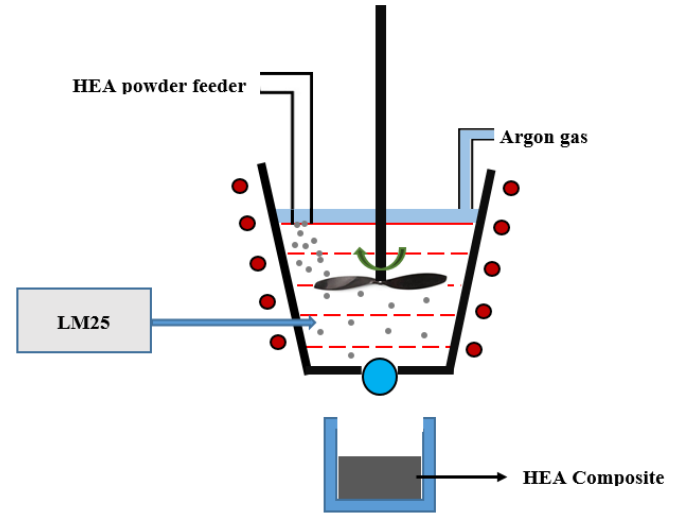
Figure 1. Schematic representation of stir casting furnace and composite production. Representative composite pieces were cut from the cast bar and subjected to standard metallographic sample preparation techniques (using standard metallographic procedures), and finally were etched with Kellar’s reagent. The microstructures of the composites were observed under an Olympus GX41 inverted microscope. A field-emission scanning electron microscope (FESEM, Gemini-300, ZEISS, Jena, Germany) with a combined energy- dispersive X-ray spectroscope (EDS) feature identified elemental composition as well as surface morphology. The X-ray diffraction analysis was carried out using a Rigaku Ultima IV XRD unit (Rigaku, Stuttgart, Germany) (with Cu-K α radiation: λ : 1.5406 Å), which functioned at 30 mA and 40 kV by recording diffraction patterns at a scan rate of 0.01 ◦ from 2 θ ranging between 20 ◦ to 100 ◦ to confirm the crystal structure and phases produced. In addition, the specimens underwent a microhardness test for a load of 0.2 kg and a dwell time of 5 sec using a Shimadzu microhardness tester HMV-G20, and the values indicated are an average of the 6 to 8 values considered for the